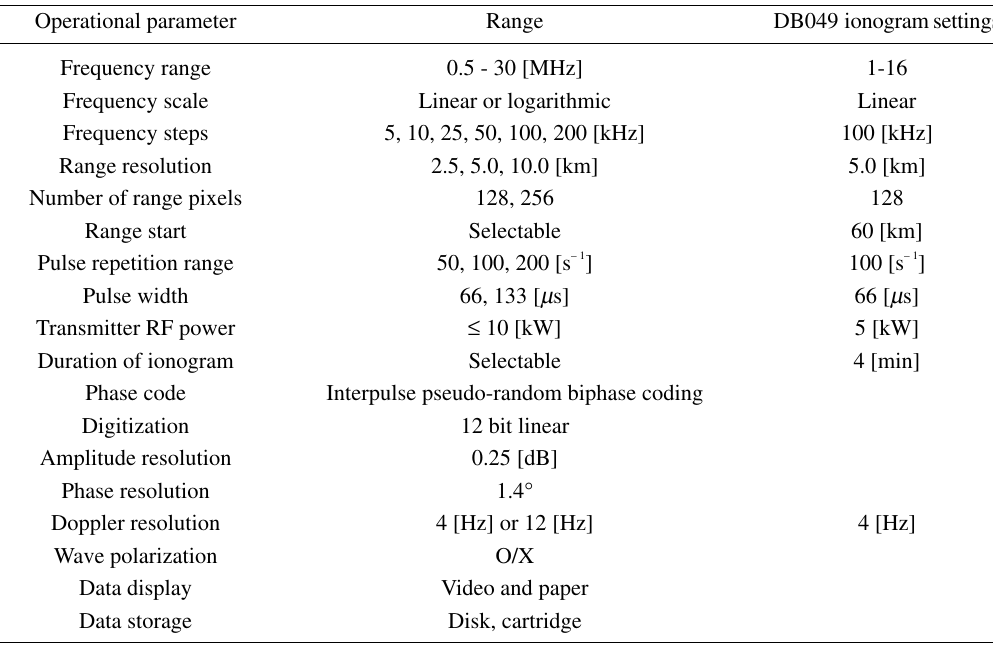
Table I. The Dourbes (DB049) digital ionosonde – operational parameters and settings (after Reinisch,